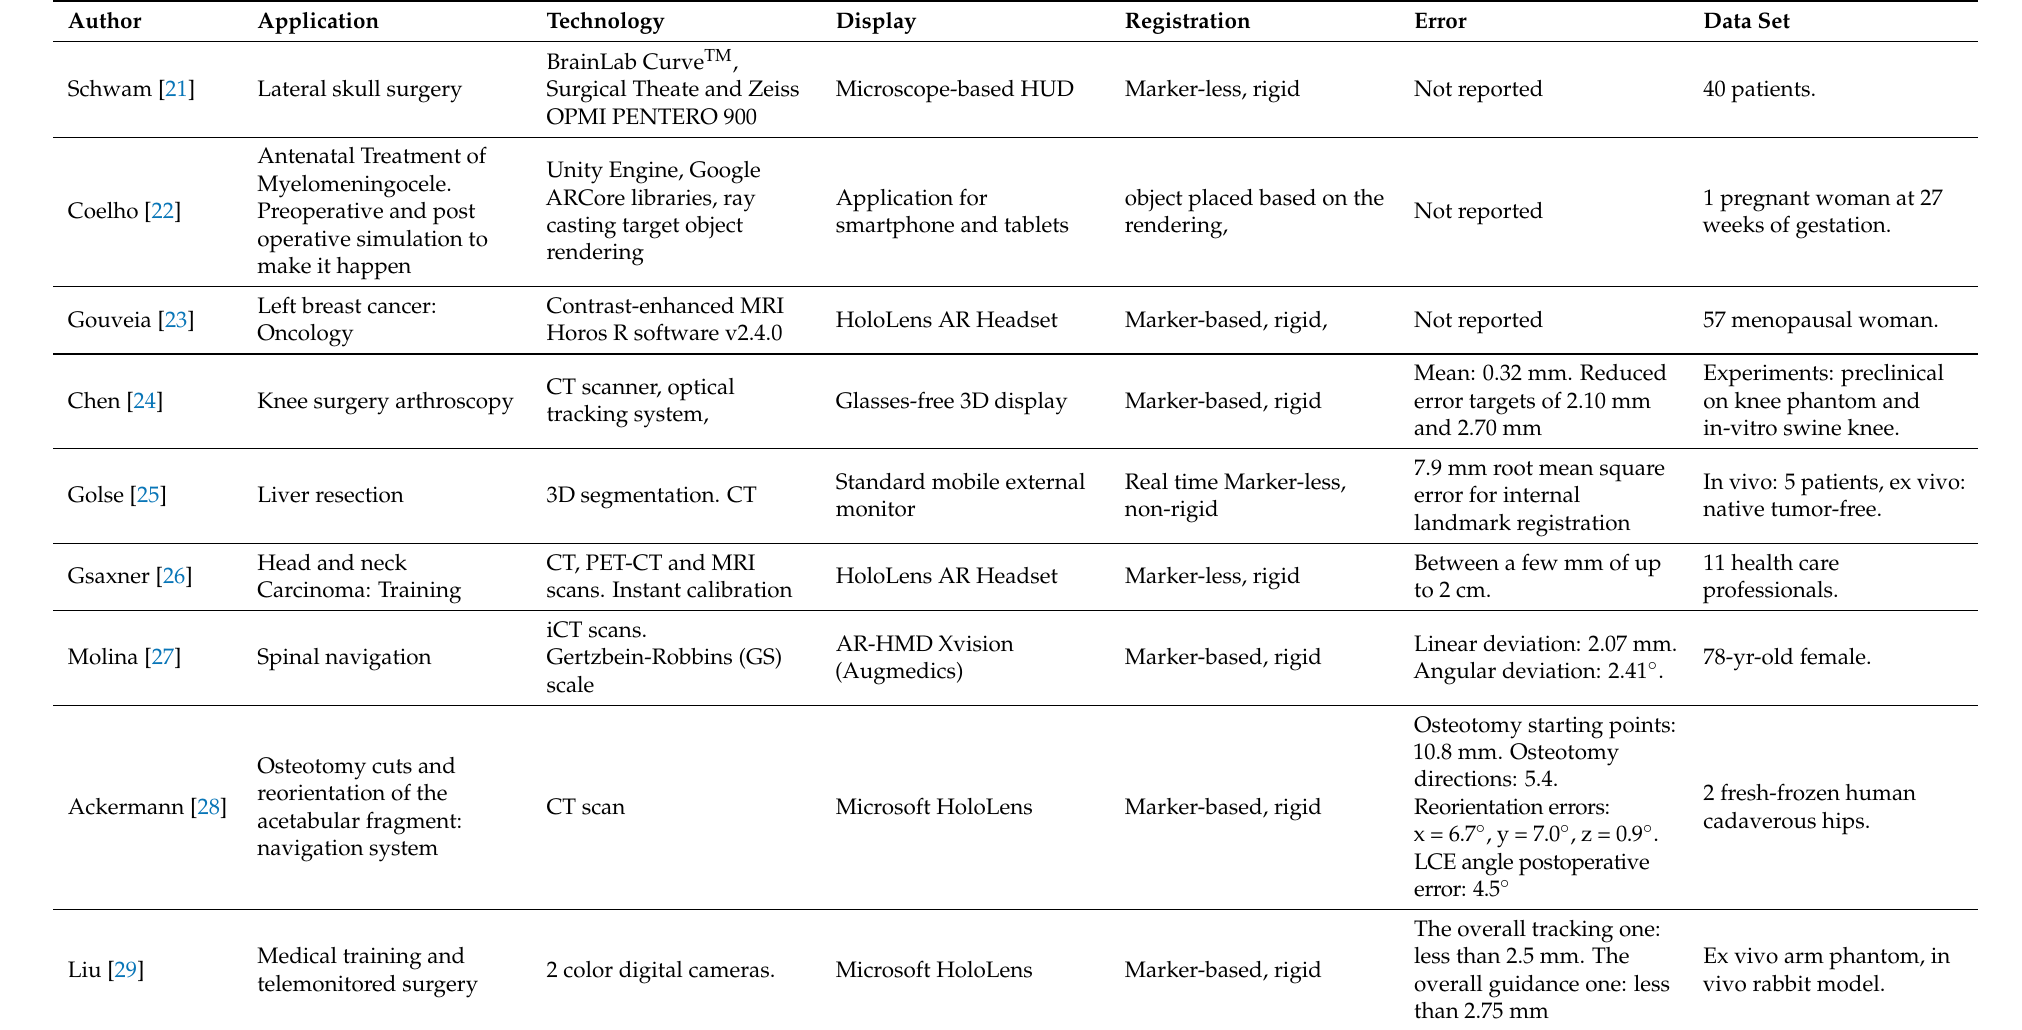
Table 1. Most recent Augmented reality application for each field and method that resulted from the